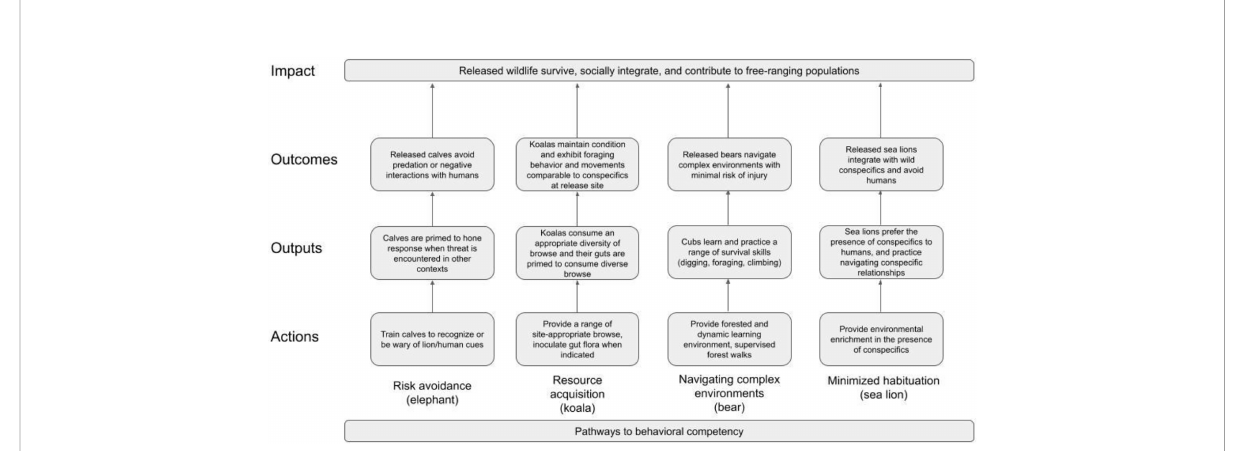
FIGURE 2 Theory of change for example interventions at the Rehabilitation II